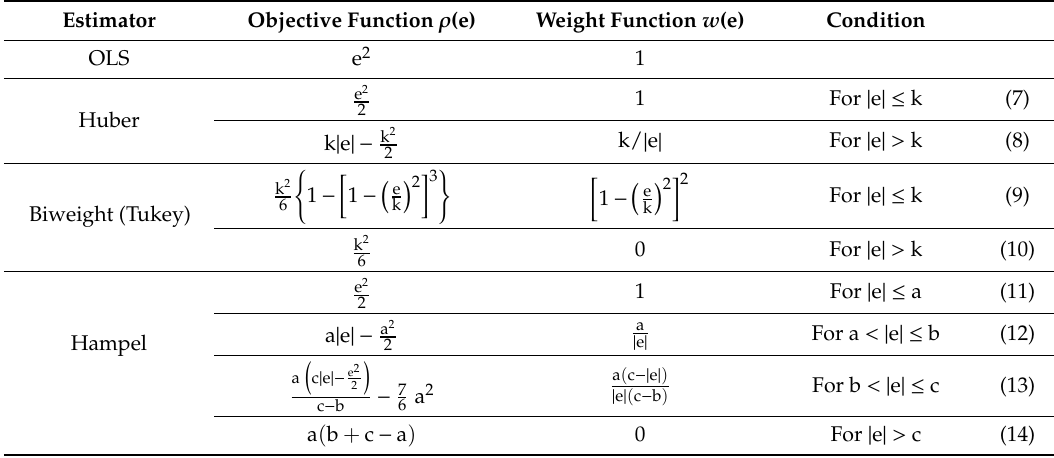
Table 5. Functions and condition of maximum likelihood estimators